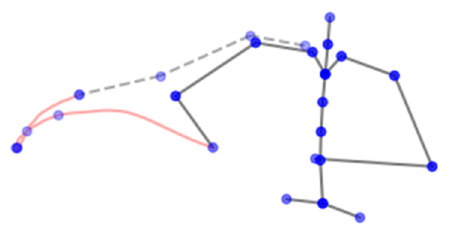
Figure 4. Skeleton hierarchy considered as the input to LSTM.